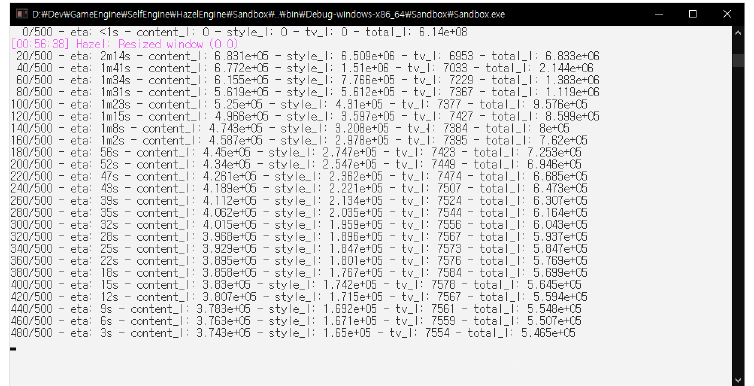
Figure 12. The console window output from the neural-network style transfer